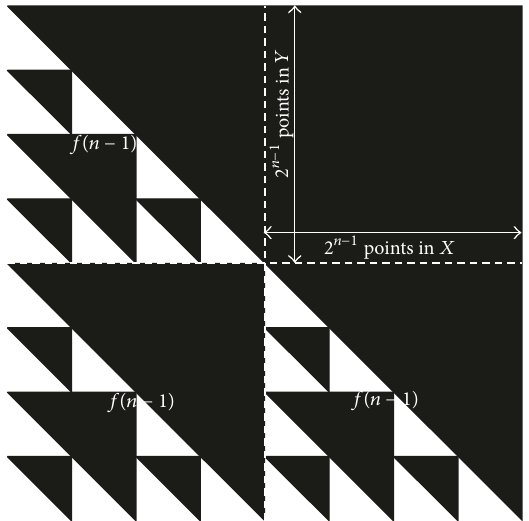
Figure 10: Total number of “redundant points”/the points in the darkened region, by deriving a recursive formula for 𝑓(𝑛) . Thus, 𝑓(𝑛) = 3 × 𝑓(𝑛 − 1) + (2 𝑛−1 ) 2 .